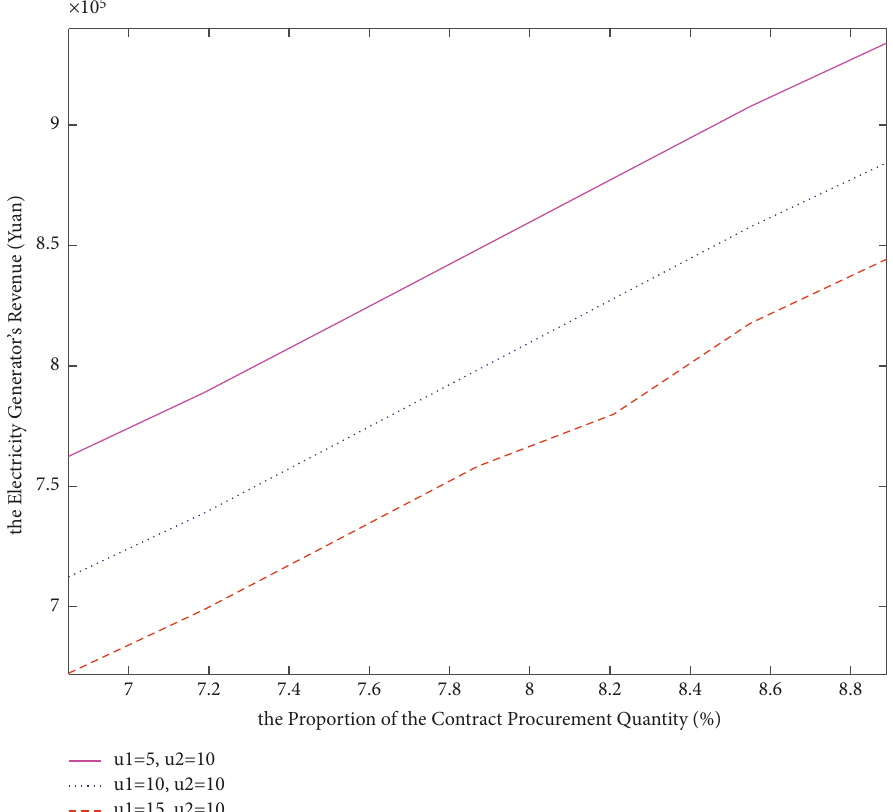
Figure 5: The impact of the proportion of the contract procurement quantity on the electricity generator’s